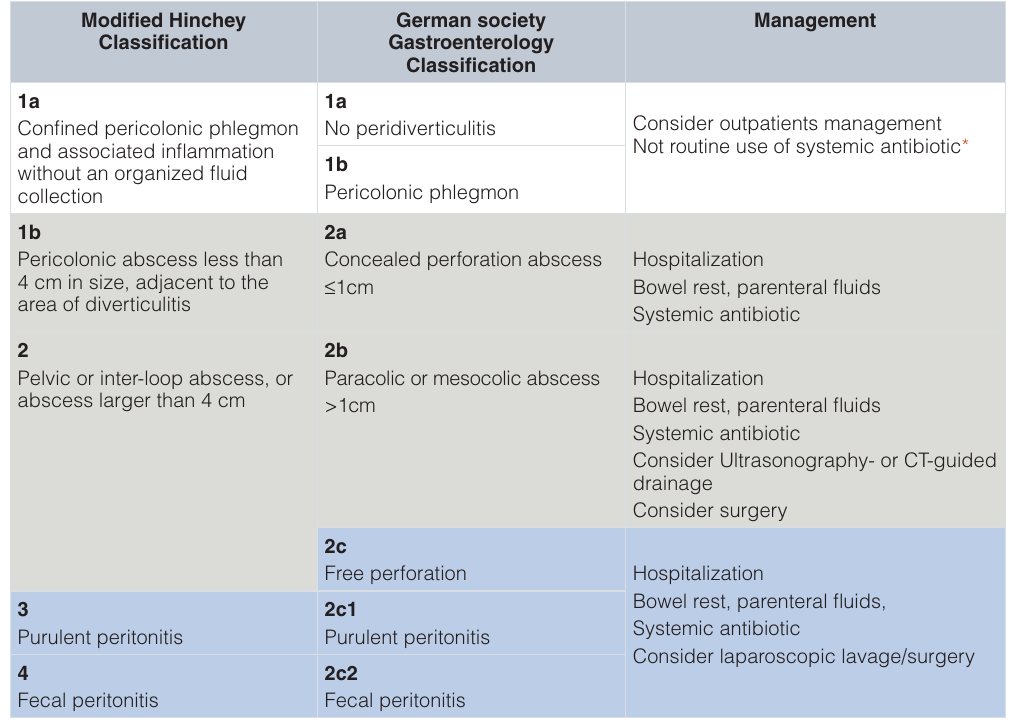
Table 2. Acute diverticulitis management and classification according to modified Hinchey and German Society Gastroenterology